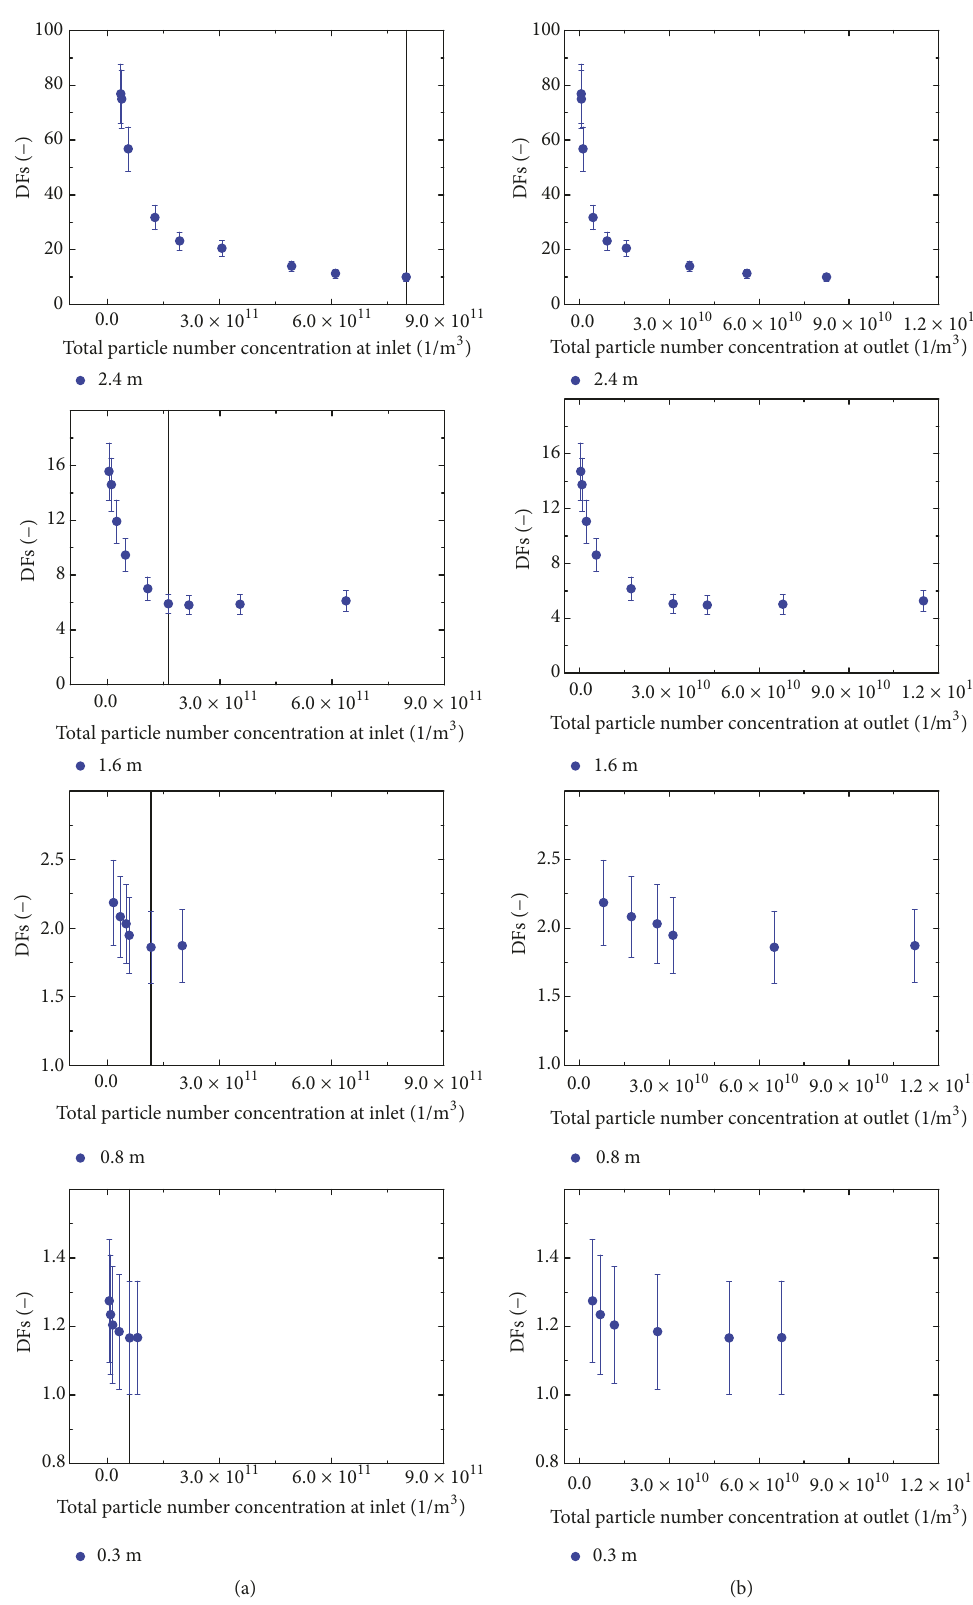
Figure 6: DFs in all water submergences against total particle number concentrations (a) at inlet and (b) at